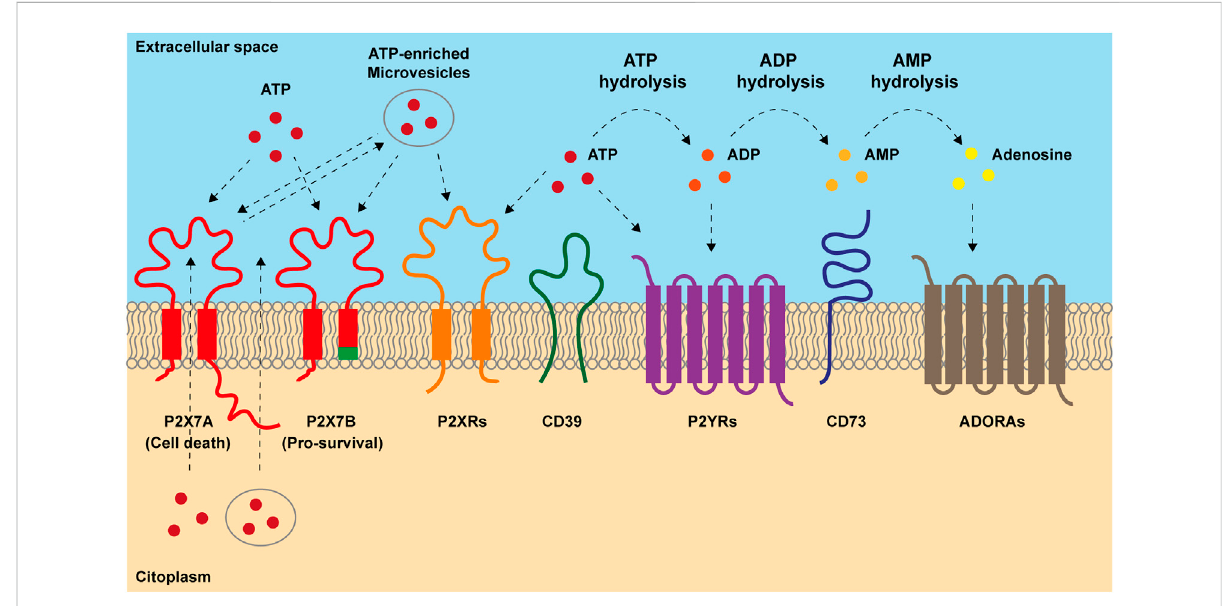
Main components of purinergic signaling. ATP is released into extracellular space both passively, after cellular lysis, and actively, through exocytic vesiscles, exosomes and plasma-membrane derived vesicles or through transporters and channels including the P2X7 receptor. Once accumulated out in the extracellular milieu, ATP acts on P2X and P2Y receptors. P2X7 response to ATP depends on which isoform is engaged. Full- length P2X7A isoform exerts both channel and macropore cytotoxic activities eventually triggering cell death after prolonged stimulation. Truncated P2X7B variant retains only the ion channel activity and does not form the cytotoxic macropore resulting in therapy resitance and tumor growth. In the extracellular milieu, ATP can be hydrolyzed by ectonucleotidases CD39 and CD73 into ADP, AMP and adenosine (ADO). ADP can activate P2Y 12 receptor and ADO acts on adenosine receptors (ADORAs). ADO can be further hydrolyzed in inosine by adenosine deaminase.